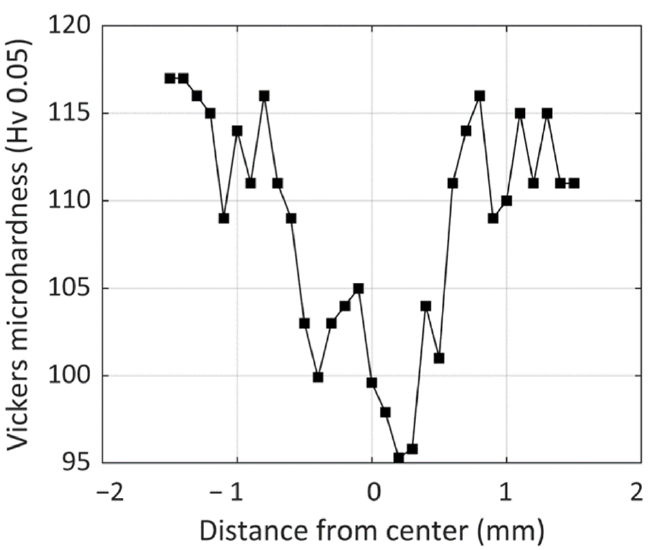
Figure 12. Microhardness variation across the weld (BM, HAZ, and FZ regions) for the sample with an oscillation amplitude of 0.6 mm and oscillation frequency of 300 Hz.